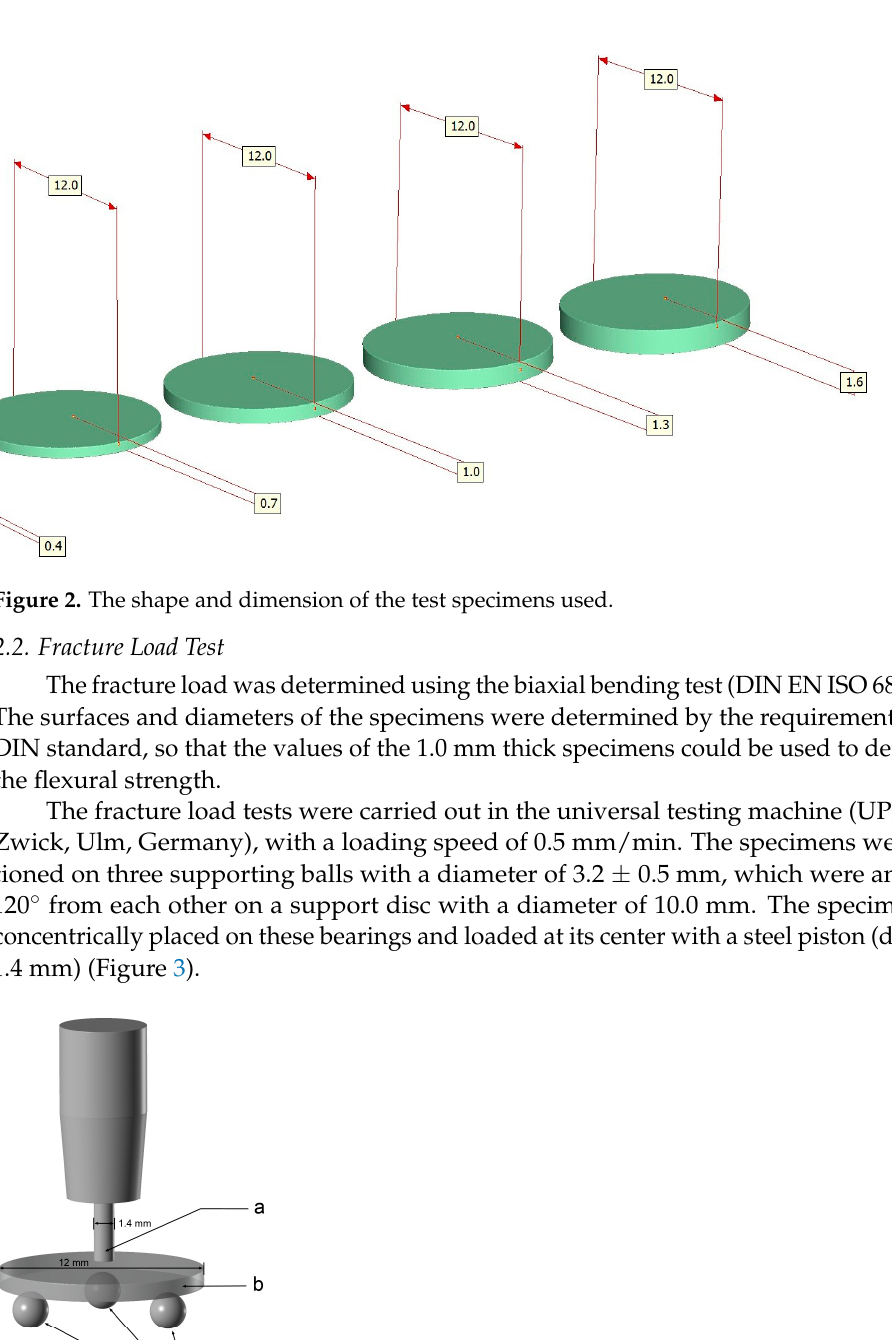
Figure 3. Schematic drawing of the biaxial bending test (DIN EN ISO 6872) (a. steel piston; b. test specimen; c. supporting spheres placed in a circular manner at 120° from each other).